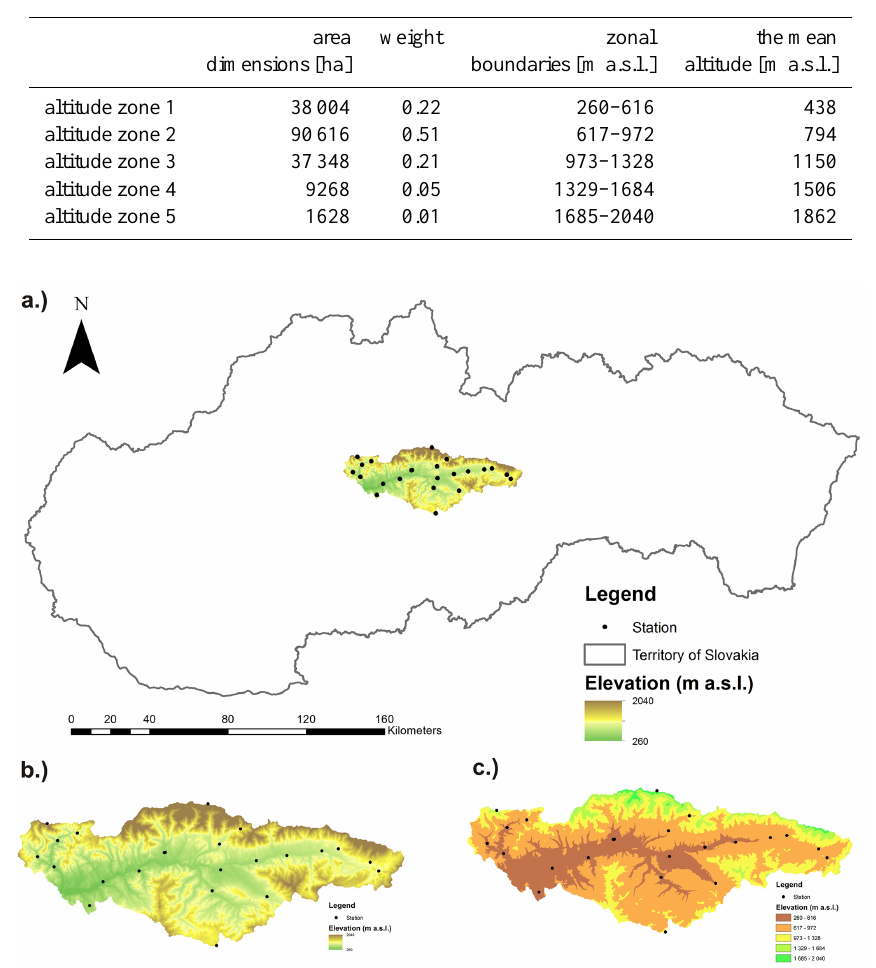
Table 1. List of the altitude zones.